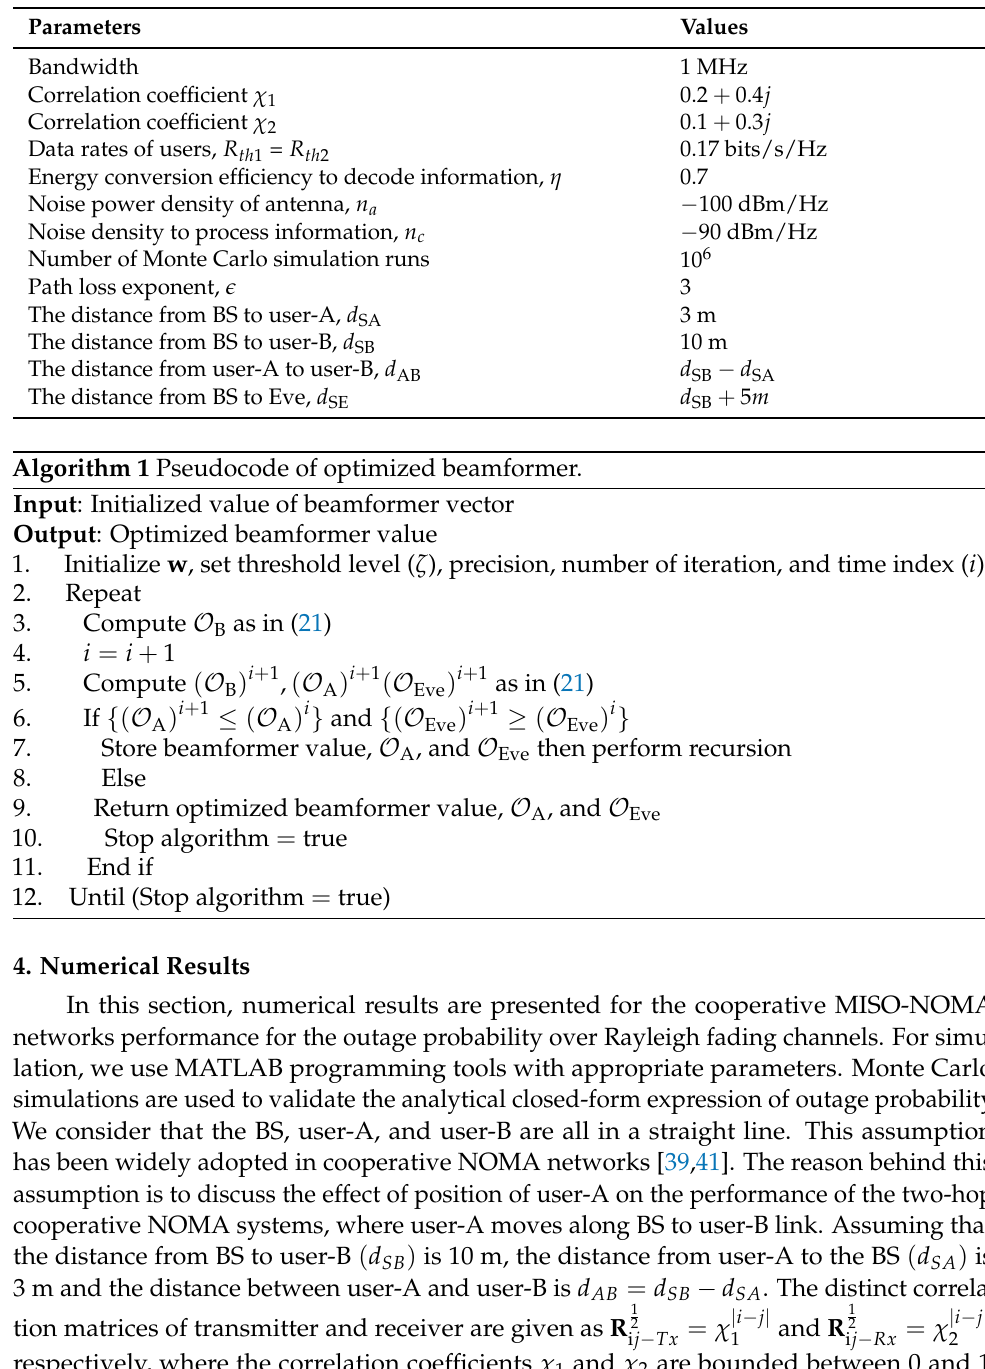
Table 1. Simulation parameters.